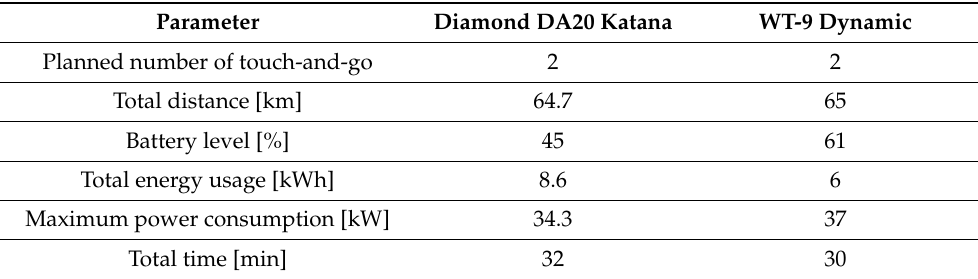
Table 9. Comparison between DA20 Katana and WT-9 Dynamic—touch-and-go procedure.